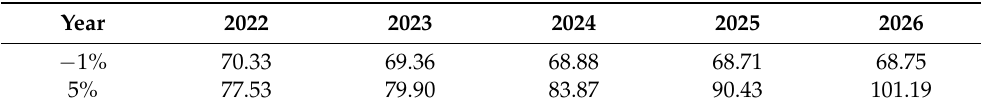
Table 22. Prediction result of water requirement with different growth rates of AVTI in Shanxi Province.